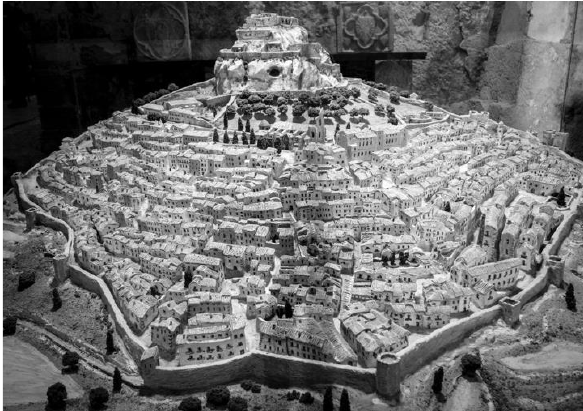
Figure 2. Picture of the urban model of Morella, on display in the Palacio del Gobernador, in the Castle (Source: S. Portela, 2018).